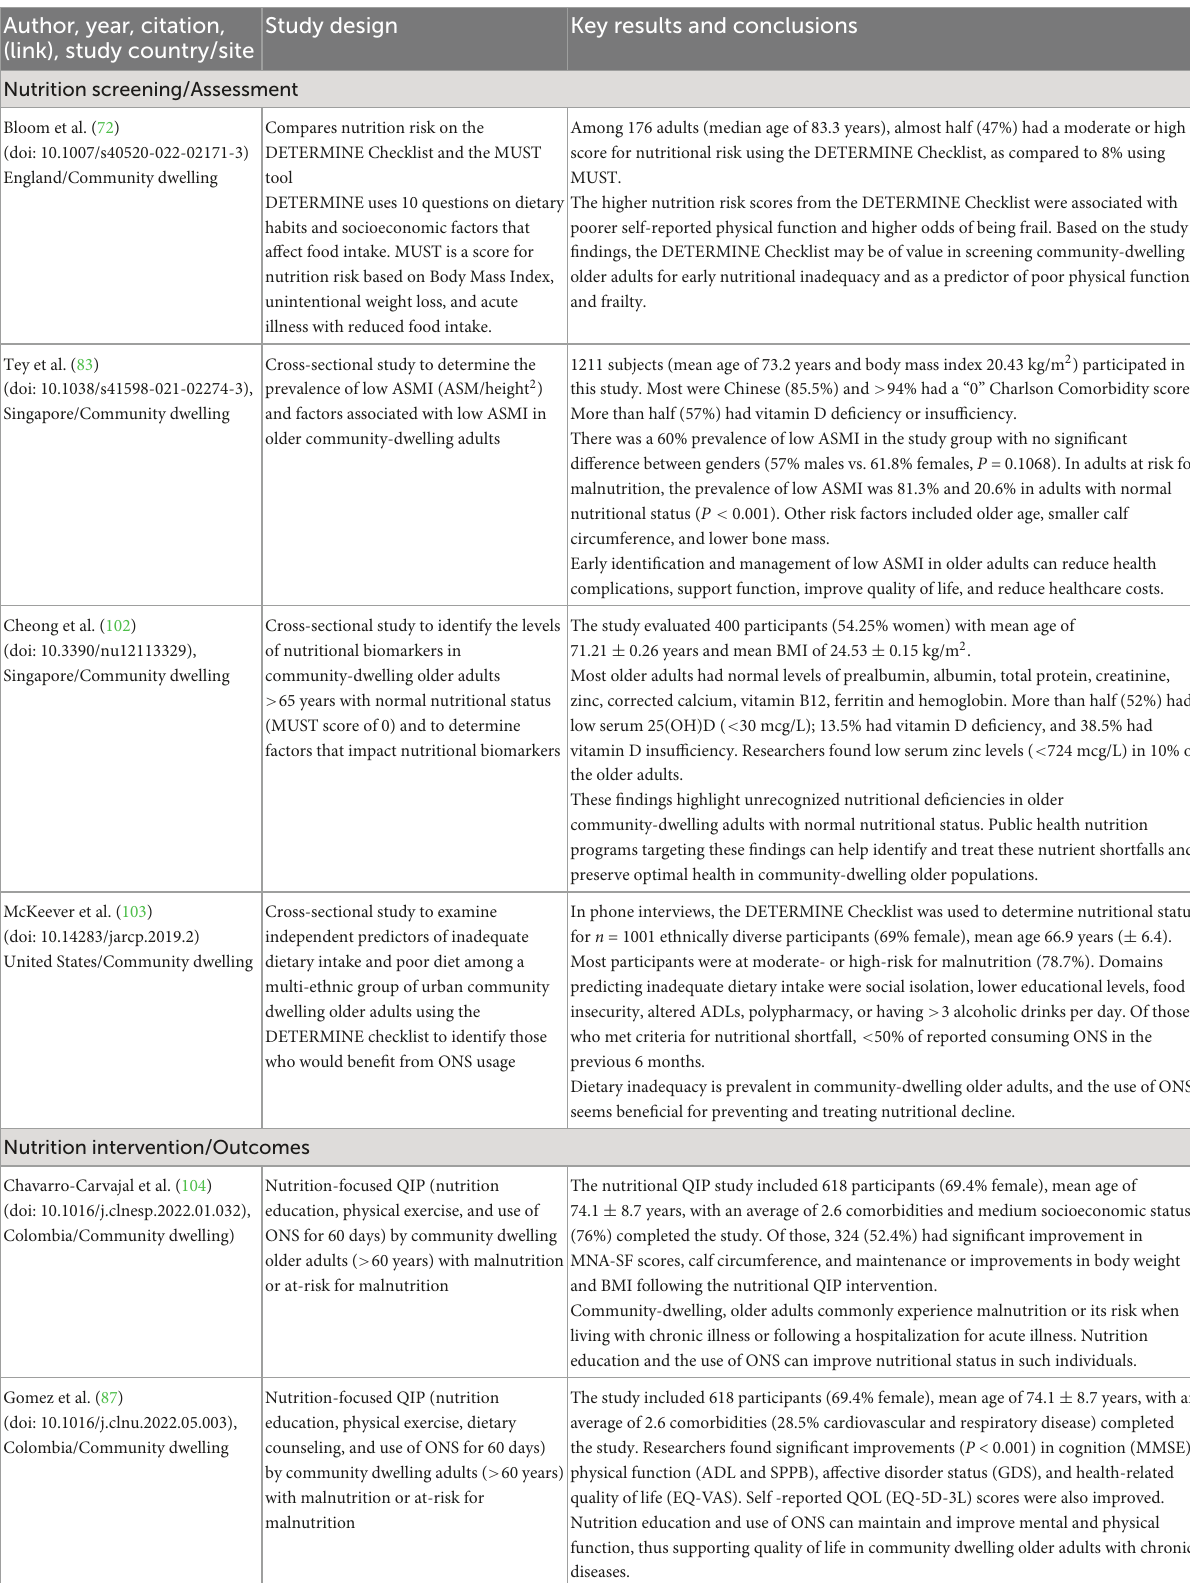
TABLE 1 Recent studies on nutritional interventions to support healthy aging in older